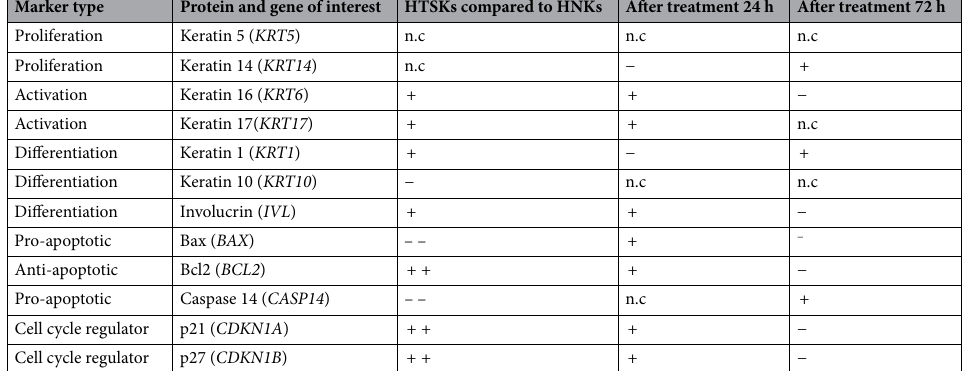
Table 3. Impact of the effect of ESWT on human hypertrophic scar keratinocytes. + indicates fold change from control < 2.0. + + indicates fold change from control > 2.0. − indicates fold change from control 0.0 to −0.5. – – indicates fold change > −0.5. n.c not